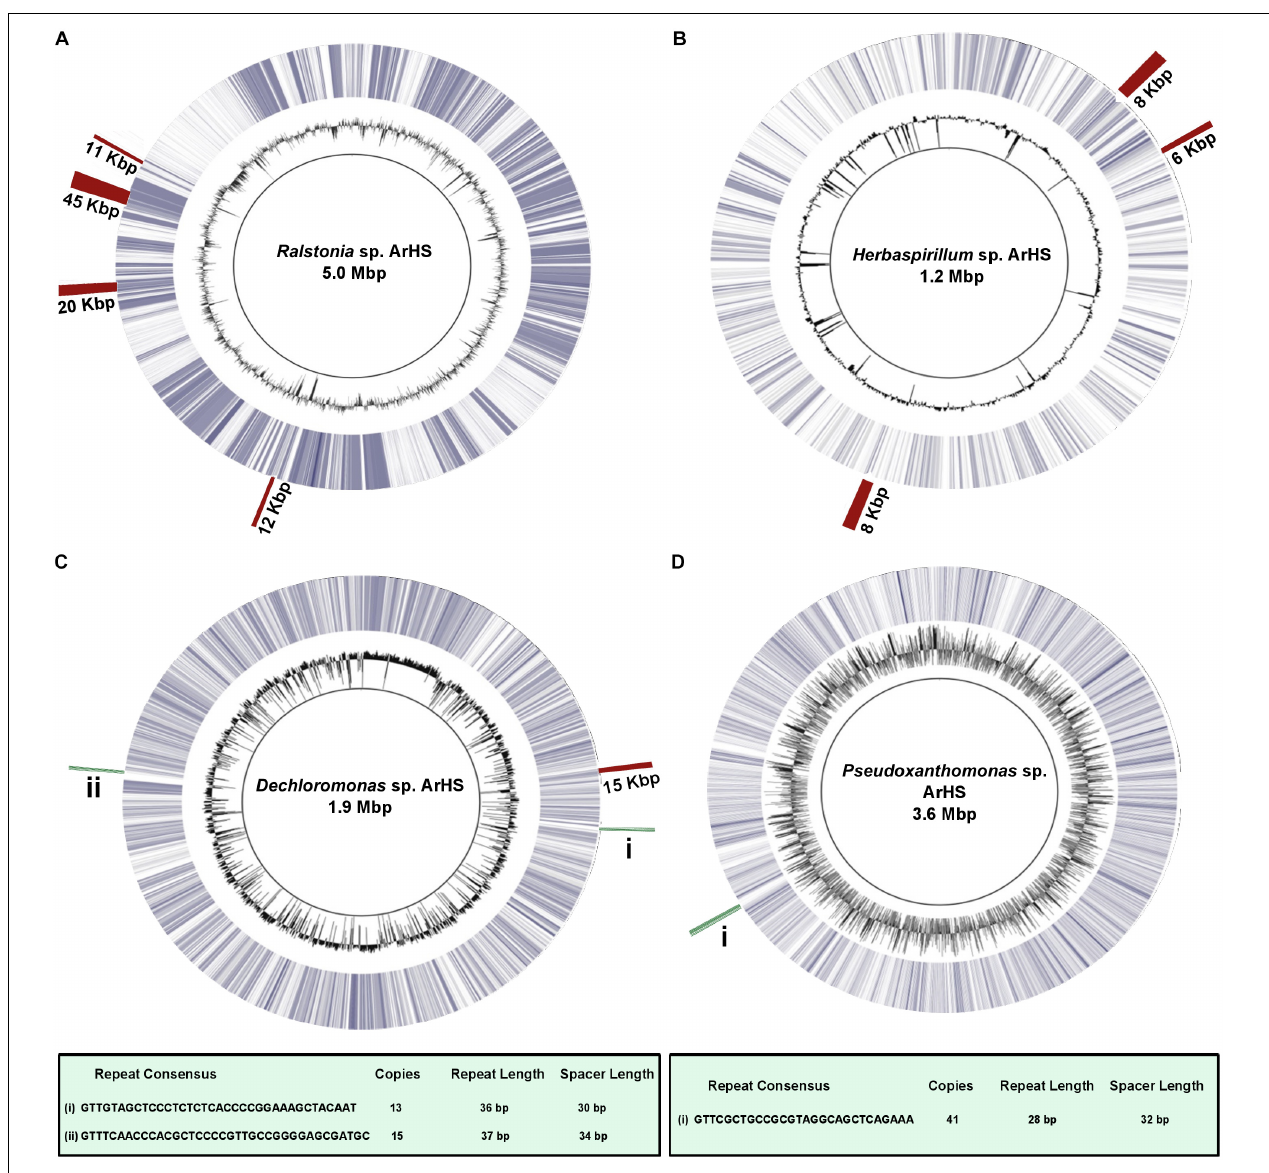
FIGURE 5 | Circular alignments of reconstructed genotypes of (A) Ralstonia sp. ArHS, (B) Herbaspirillum sp. ArHS, (C) Dechloromonas sp. ArHS, (D) Pseudoxanthomonas sp. ArHS with respect to their closest reference genotypes, i.e., Ralstonia solanacearum GMI1000, Herbaspirillum seropedicae SmR1, Dechloromonas aromatica RCB, Pseudoxanthomonas suwonensis 11-1. A near complete genome (5.04 Mb, contigs = 255, reads = 2,81,07,606) of Ralstonia sp. ArHS was recovered based on the conserved bacterial genes [31/31 single copy genes (Wu and Scott, 2012) and 106/107 essential genes (Dupont et al., 2012)]. However, only partial genomes were recovered for Herbaspirillum sp. ArHS (1.2 Mb), Dechloromonas sp. ArHS (1.9 Mb), and Pseudoxanthomonas sp. ArHS (3.5 Mb) with less than 95% of conserved genes. From center toward outside; Ring 1 (solid black line): reconstructed bacterial genome, Ring 2 (black): G+C content, Ring 3 (blue): bacterial reference genome, and Ring 4: homologous region between prophages (red) or CRISPR arrays (green) and the reconstructed bacterial